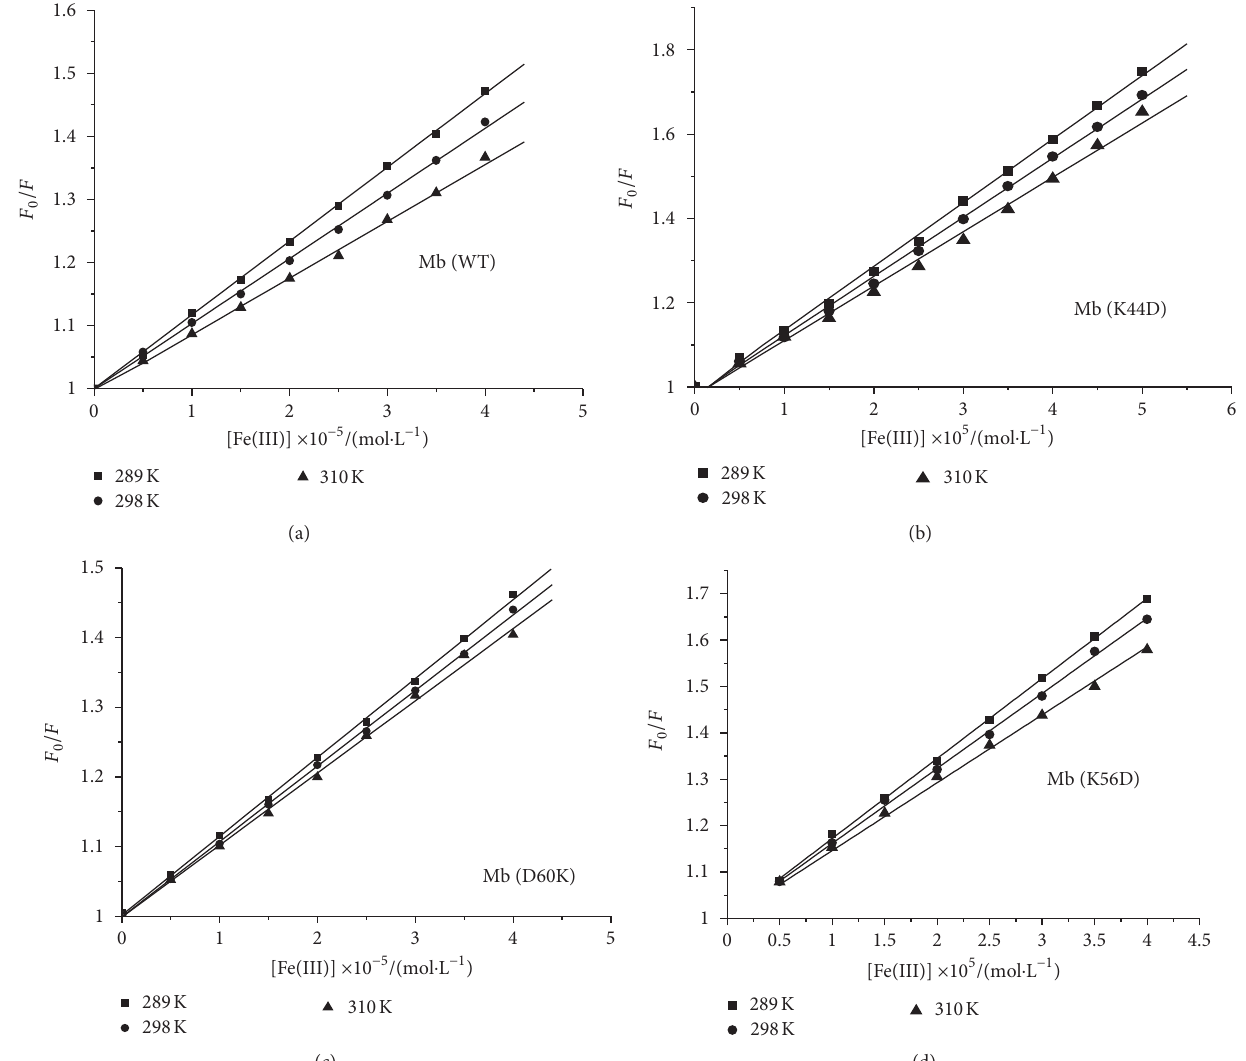
F 3: Stern-Volmer plot of several Mbs quenched by Fe(III) at different temperatures.